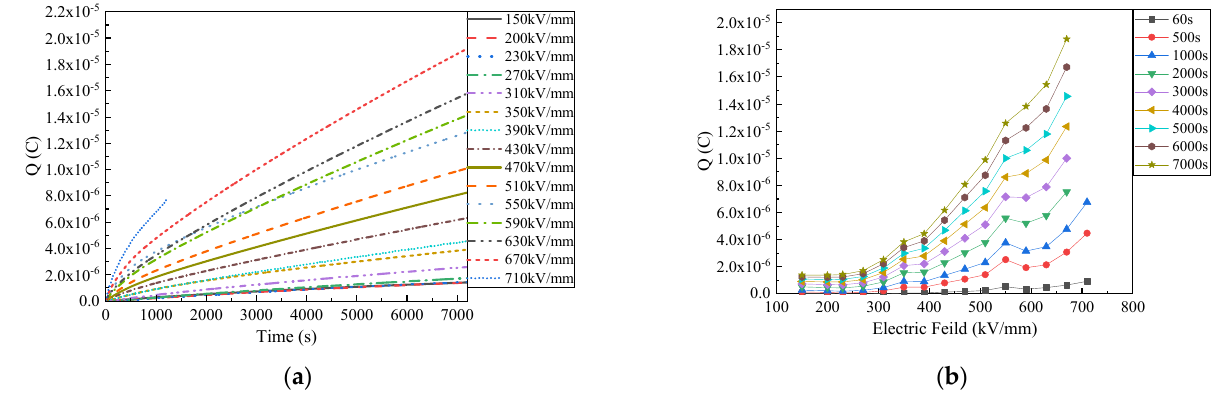
Figure 6. The space charge accumulation of PP films. (( a ): Q versus time; ( b ): Q versus electric field).